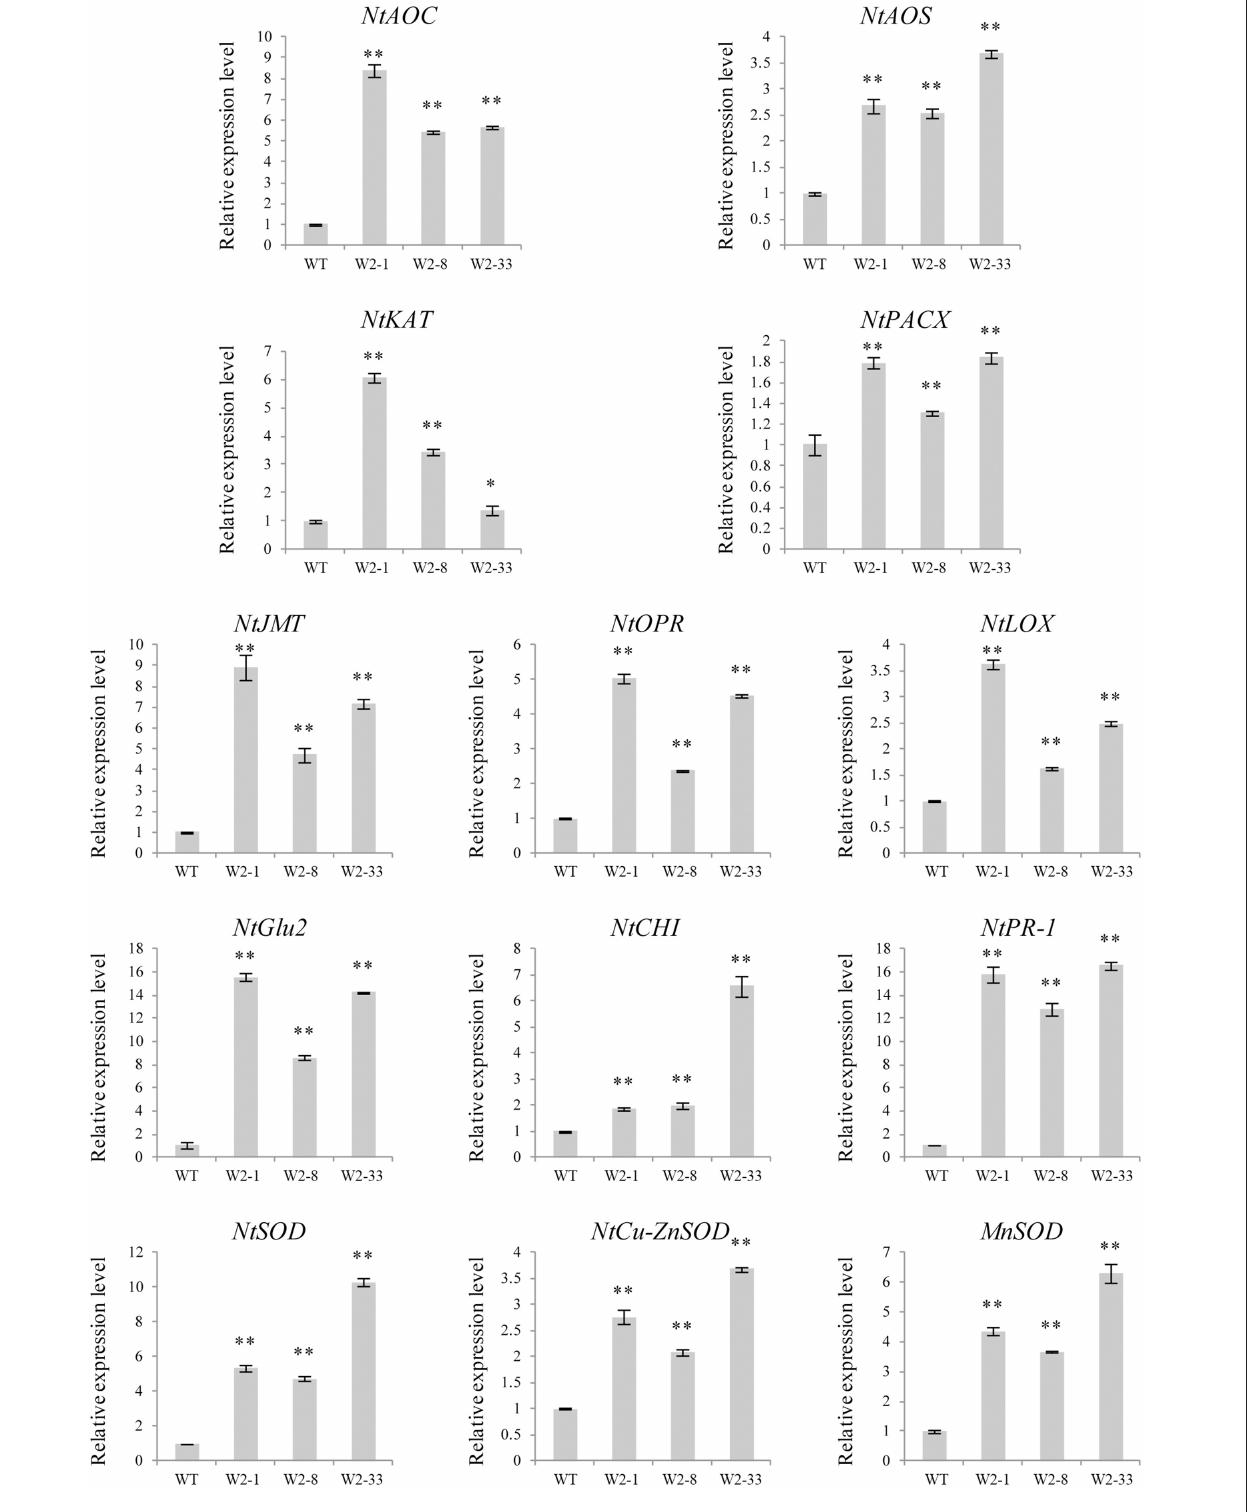
Frontiers in Plant Science |